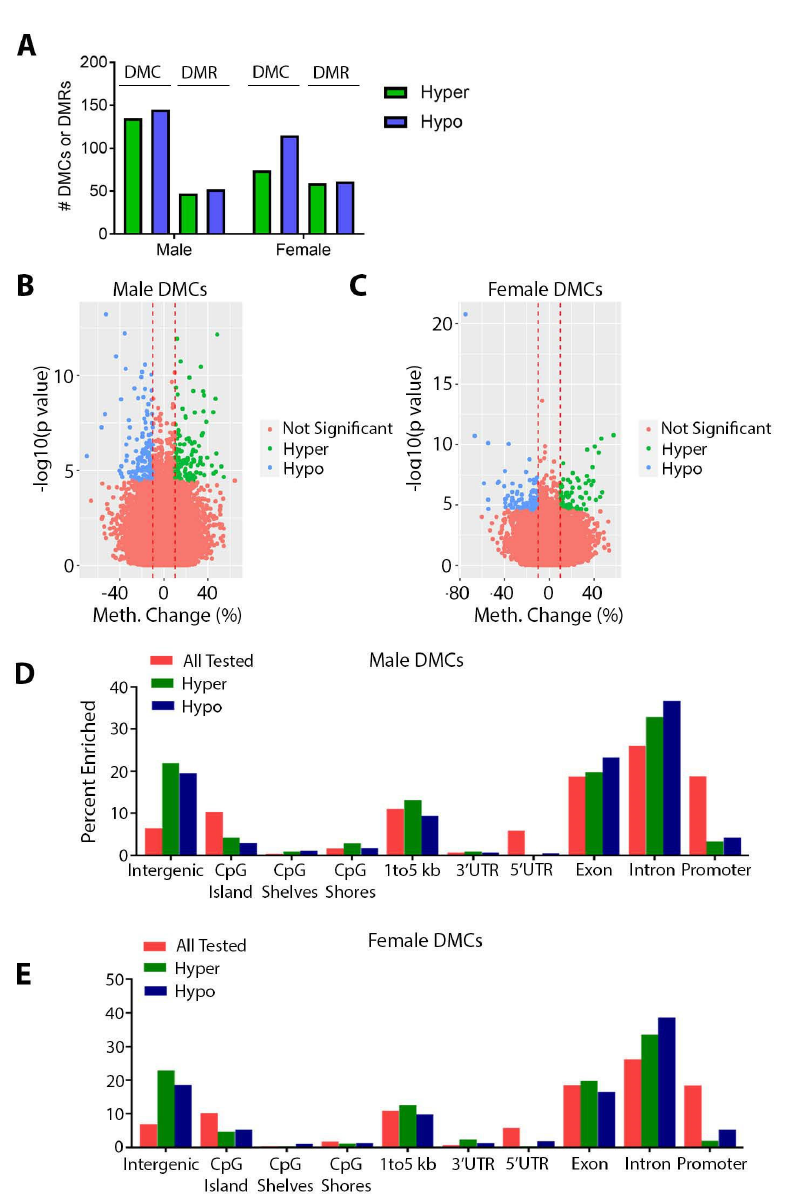
Figure 4. ERRBS in weanling offspring mouse hearts. ( A ) Numbers of differentially hyper- and hypomethylated cytosines (DMCs) and regions (DMRs) in male and female hearts. ( B , C ) Volcano plots depicting DMCs in males and females. CpGs with FDR <0.05 and at least 10% absolute change in DNA methylation were considered significant. ( D , E ) Annotation summary plots depicting the total number of CpGs tested in pink, hypermethylated DMCs in green, and hypomethylated DMCs in blue for each genomic annotation using the R annotatr package for males ( D ) and females ( E ). 3.3. Sex Specificity of Pb-Induced Changes in DNA Methylation Changes in DNA methylation with Pb exposure at weaning were, as in adulthood [44], highly sex-specific, with no DMCs or DMRs directly overlapping between sexes. In males, 185 and 64 DMCs and DMRs, respectively, mapped to genes, while in females 120 and 80 DMCs and DMRs, respectively were associated with genes (Figure 5A,B). When